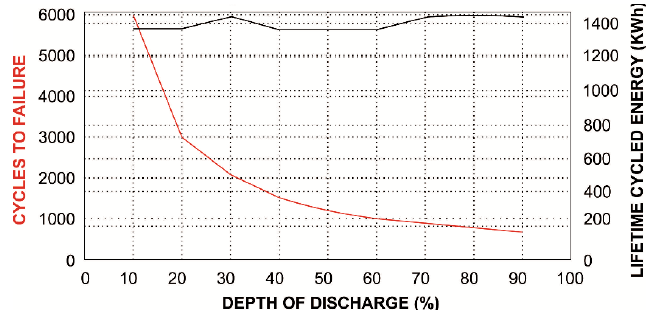
Figure 3. Cycles to failure vs. depth of discharge for a battery. Table 4. Inverter characteristics. Table 3. Battery characteristics [32,33].